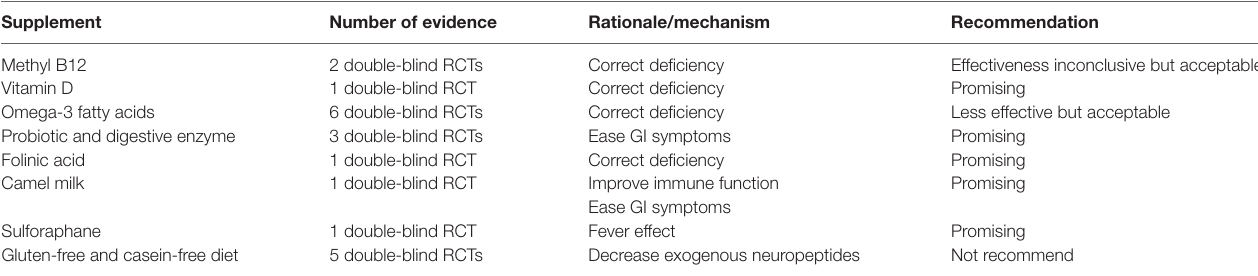
TABLe 2 | Summary of evidence and